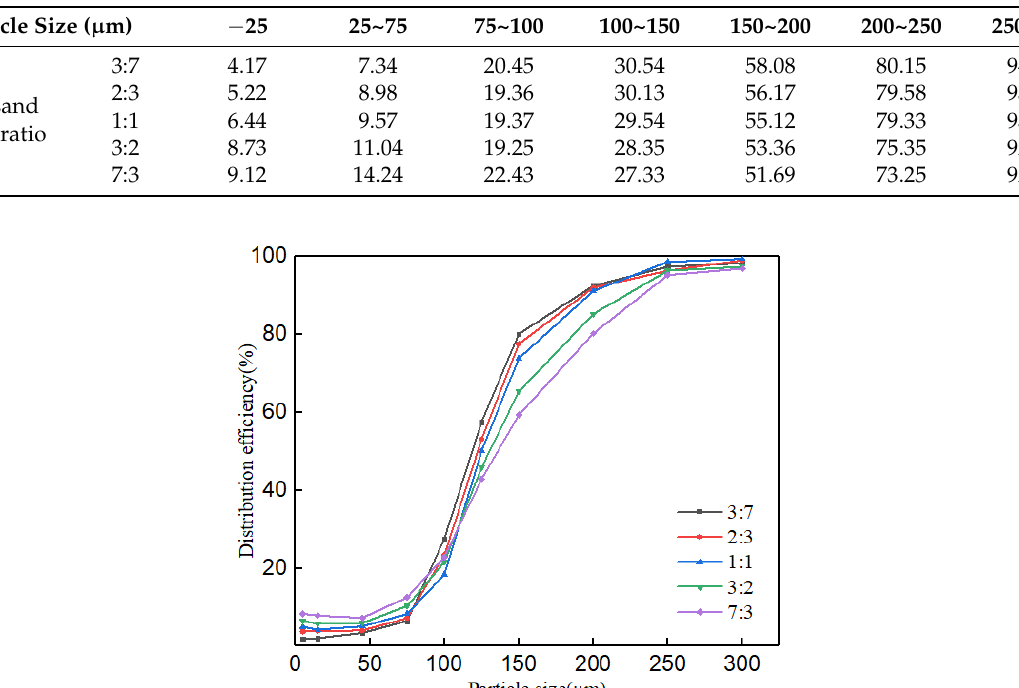
Table 6. Effect of the mud–sand mixing ratio on cumulative particle size content.